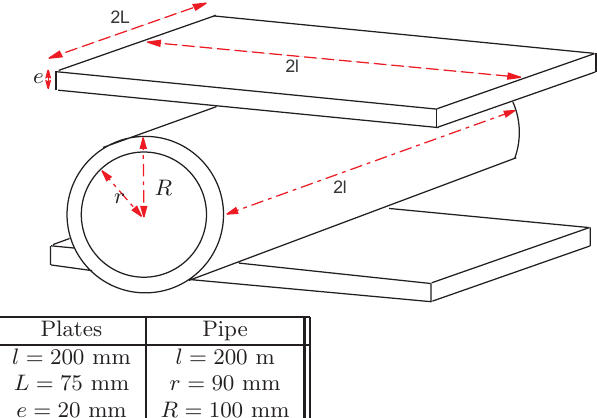
Fig. 15. Pinch of pipes: geometrical model.